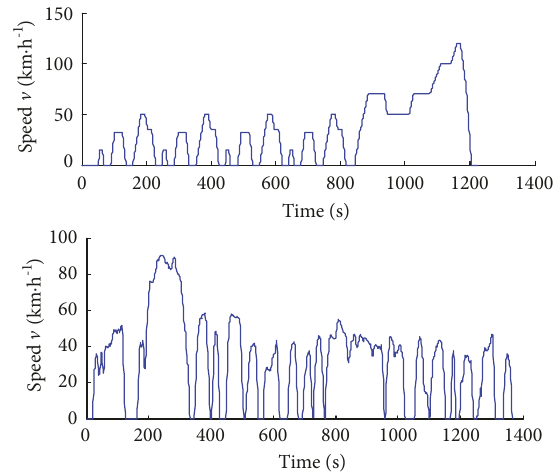
Figure 5: ECE EUDC and UDDS driving